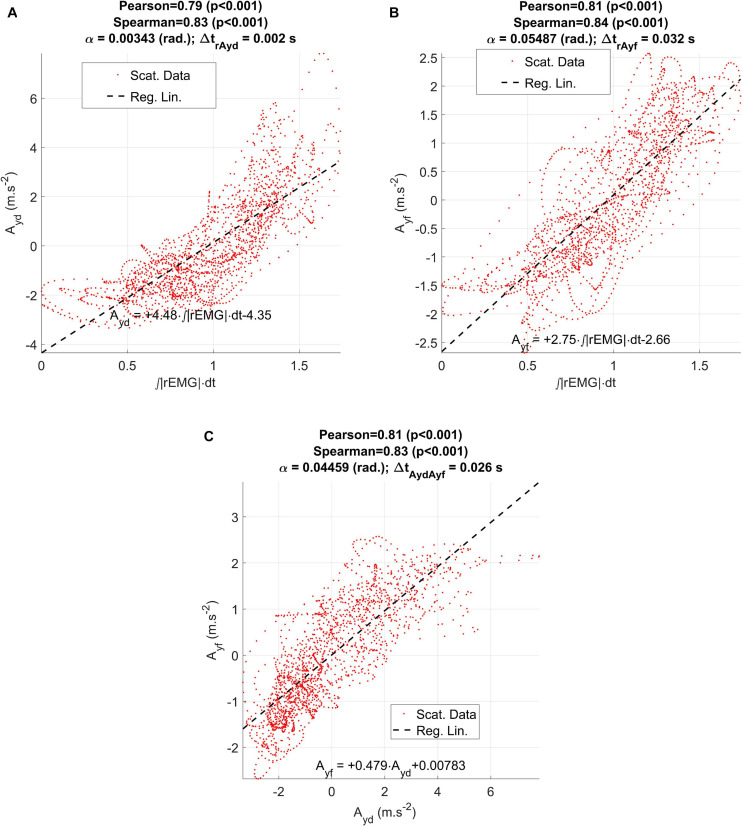
Regression results between the ECMF and the estimated accelerations (dynamical and acoustical) from the participant CMa: (A) regression plot between the vertical dynamic acceleration (Ayd) and the ECMF; (B) regression plot between the vertical acoustic acceleration (Ayf) and the ECMF; (C) regression between the vertical dynamic and acoustic accelerations.